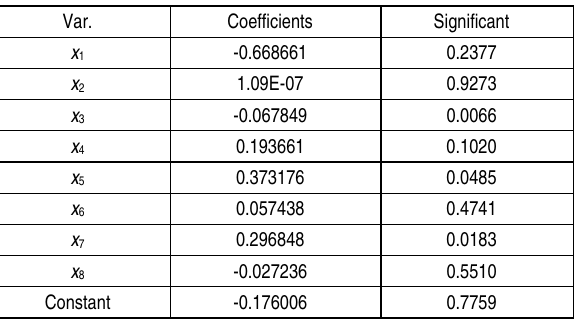
Table 7. The 2 nd model coefficients